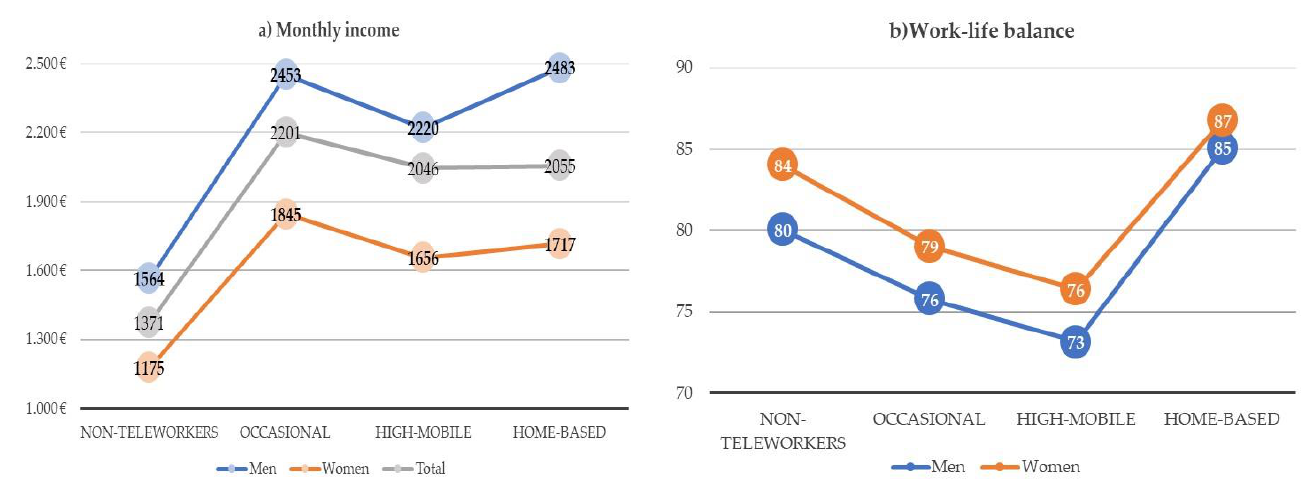
Figure 3. ( a ) Mean values of monthly income (in euro), and ( b ) work–life balance (in % of workers) by type of telework and gender in the EU28 (weighted). Source: Own elaboration based on Sixth EWCS data.